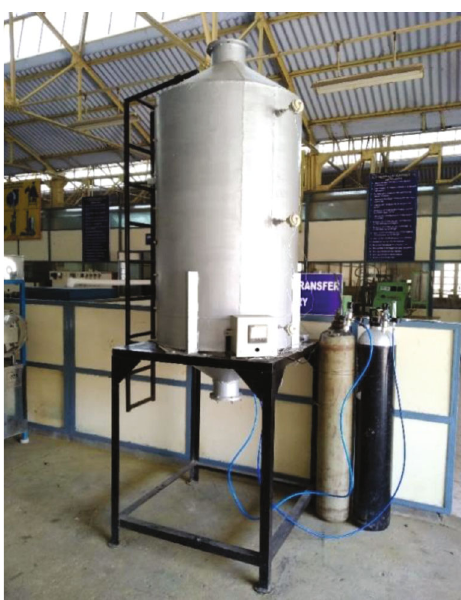
Figure 3: Experimental setup of controlled atmosphere storage bin for black gram